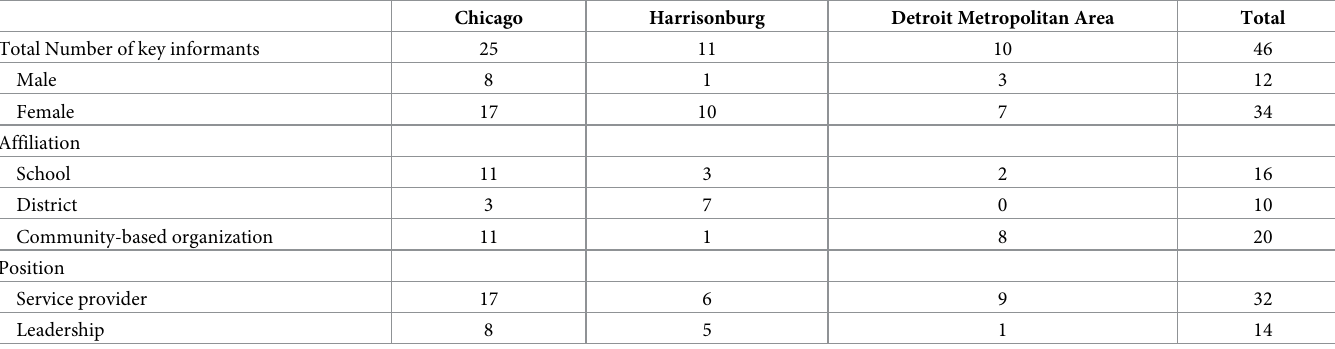
Table 1. Key informants by location, position and